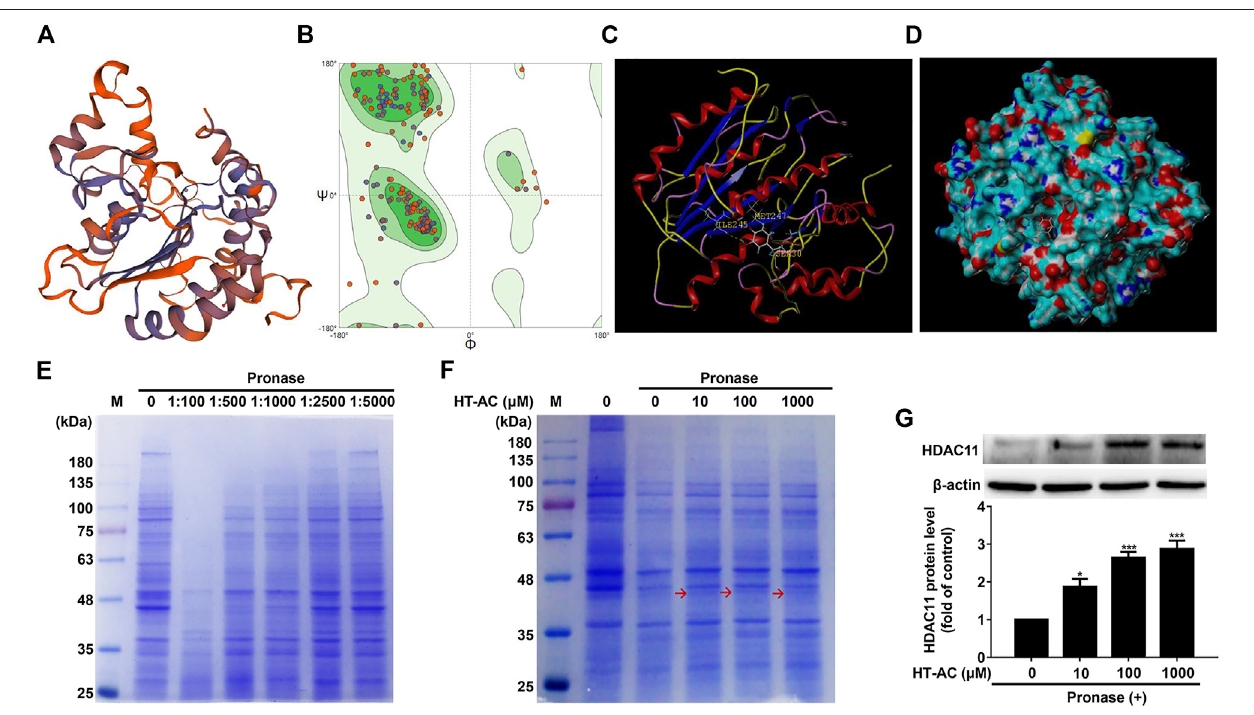
FIGURE 5 | HT-AC may target HDAC11 (A) Schematic SWISS-MODEL model of human HDAC11 (B) Ramachandran plot analysis of the three-dimensional structure of human HDAC11. The green, light green, and light blue regions represent the “ most favored ” , “ additional allowed ” and “ generously allowed ” regions that amino acid residue fall regions, respectively (C,D) The ability of HT-AC to bind to the HDAC11 ligand-binding domain by molecular docking (E) Cell lysates were subjected to pronase digestion at various mass ratios of pronase to protein (1:100, 1:500, 1:1,000, 1:2,500 and 1:5,000) and coomassie staining (F) After treatment with HT-AC (10, 100 and 1,000 μ mol/L) for 2 h at 4 ° C, cell lysates were subjected to pronase digestion at the 1:1,000 pronase to protein mass ratio and coomassie staining (G) The protein expression of HDAC11 was examined by Western blotting in HUVECs following HT-AC treatment. * p < 0.05 and *** p < 0.001 vs. control group. Results are expressed as mean ± SEM ( n (cid:2)